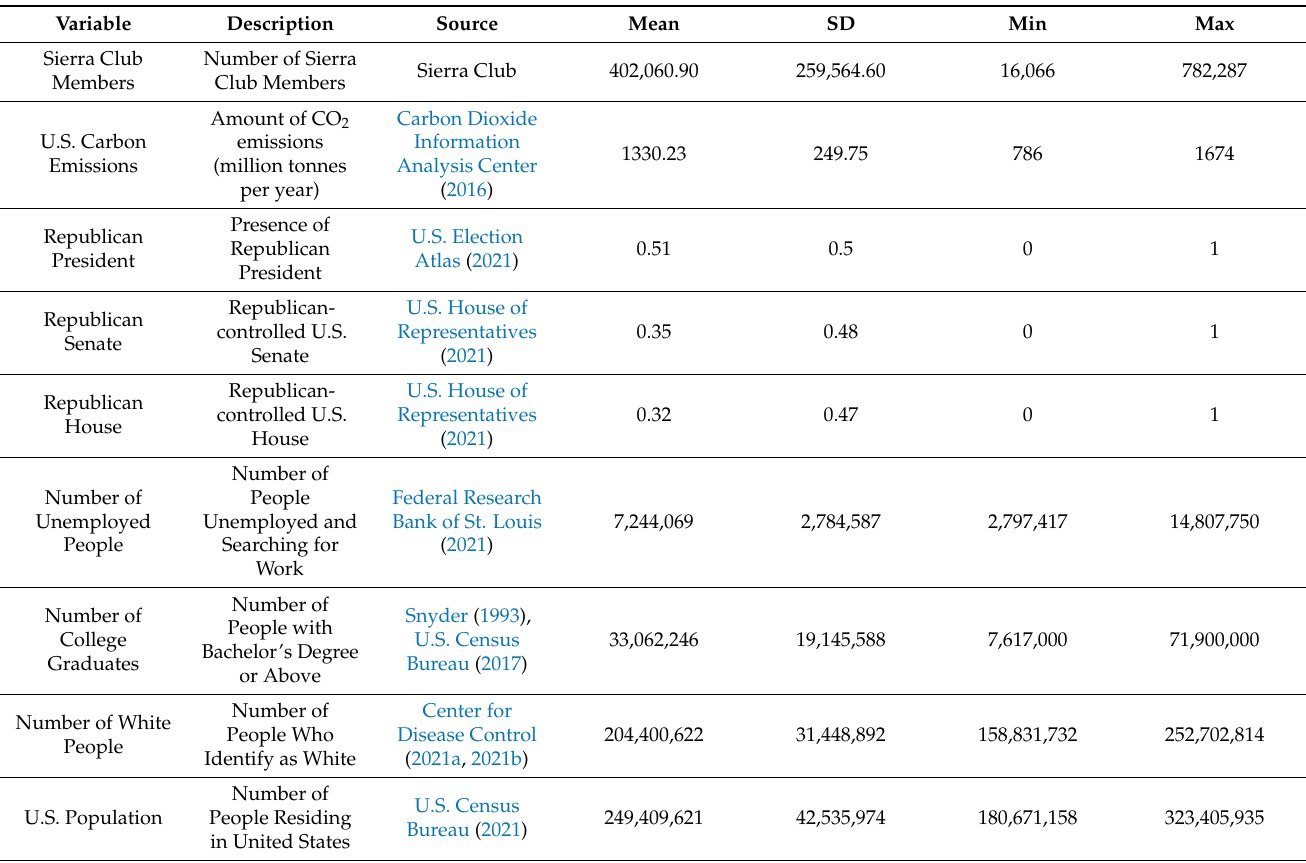
Table 2. Descriptive Statistics 1